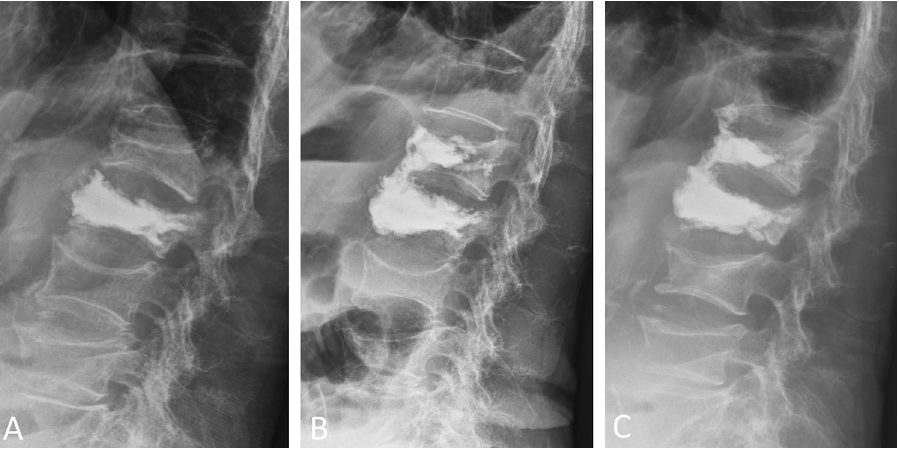
Figure 4. ( A ) A 95-year-old woman sustained a new-onset adjacent L1 compression fracture 3 weeks after L2 vertebroplasty, ( B ) the cement bridging phenomenon was observed during L1 vertebroplasty. Increased cement volume of the previously cement-augmented L2 vertebrae was noted compared with the preoperative image. ( C ) Two years postoperatively, the focal kyphotic angle and bony alignment were